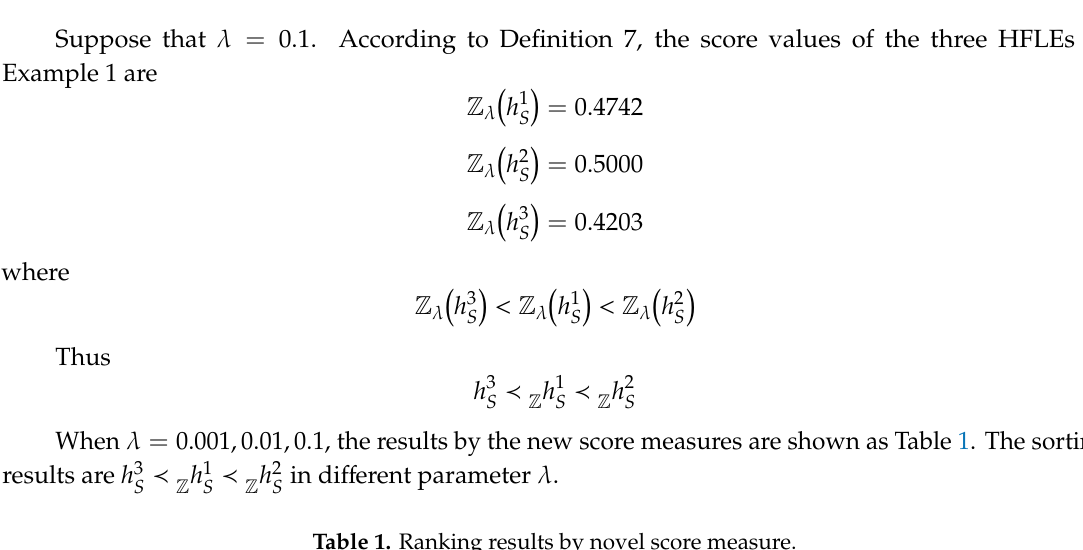
Table 1. Ranking results by novel score measure.